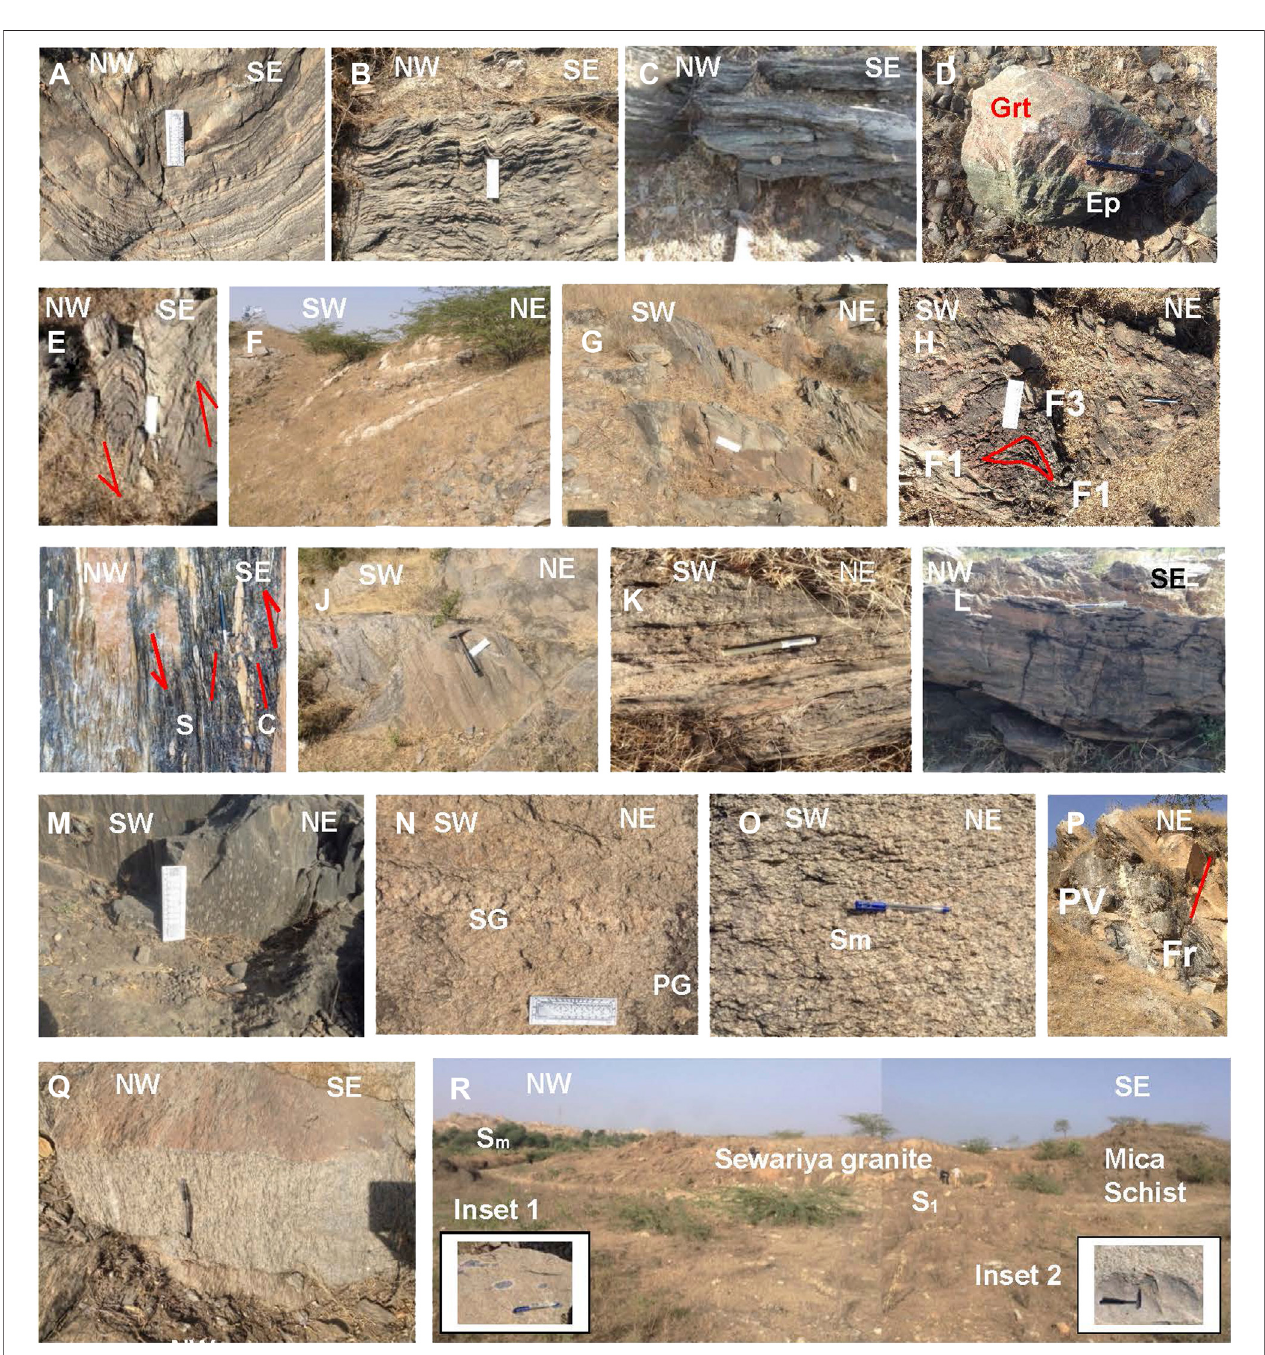
FIGURE 3 | (A) Mica schist, showing hinge zone of a large scale F 1 fold, S 1 fabric (scale parallel) is developed parallel to the axial plane of the fold, S 1 fabric crosscut the S 0 (bedding, color bandings), subhorizontal view, Rupnagar. (B) Mica schist showing crenulation cleavage (scale parallel) due to folding of S 1 by upright F 2 , Rupnagar. (C) Calc schist showingrecumbentF 1 fold(coinsattheF 1 hinge),verticalview,Pratapgarh. (D) Epidote(Ep)garnet(Grt)skarnoidnearRupnagar. (E) Calcschist/impuremarbleshowinguprightF 2 fold, havingaxialplaneparallelshear(NWvergencethrust,scaleparallel),verticalview,Rupnagar. (F) CalcschistwithSewariyagranitevein,foldedbyNNW-SSEtrendingF 3 fold(scale parallel),horizontalview,Pratapgarh. (G) Domestructure(type1)duetointerferencebetweenNEtrendingF 2 andNWtrendingF 3 folds,incalcschist,verticalviewnearPratapgarh. (H) Crudetype2intpatternduetoF 3 (scaleparallel)superimposedonF 1 nearRupnagar. (I) Metaconglomerateformation,shearedatthecenter,S-Cfabrichassmallinternalangle(15 ° ),NW vergencethrusting,verticalview,Babra. (J) Mylonitesurface,subverticalstretchinglineation(hammerparallel)andlowplungingintersectionlineation(scaleparallel),verticalview,Babra. (K) Garnet,staurolite,sillimanitebearingpocketswithinmetaconglomerate,horizontalview,Babra. (L) Alternatemetarhyolite(pinkcolored)andamphibolitelayers(greencolored),vertical view,Rupnagar. (M) Amphibolitecarryingvesicles(whitepockets),verticalview,Rupnagar. (N) Pratapgarhgranitecoursegrained(PG),intrudedbySewariyagranitevein(SG),horizontal view,nearPratapgarh. (O) SewariyagranitefromthecoreoftheplutonshowingmagmaticfabricS m ,penparallel,westofBabra. (P) FaultedrockalongChangfault,northofRupnagar, brittle fractures (Fr) are present along which thin pegmatite veins are present (PV). (Q) Sewariya granite with solid state deformation fabric, S 1 , close to the host rock contact. (R) LandscapeviewofSewariyagranitenearBabra,ontheNWside,inthecoreofthepluton,magmatic/submagmaticfabric,S m ,ismoreprominentandintheSEsidenearmicaschist contact, solid state S 1 fabric is more prominent (scale parallel) (width of the photograph 2 km).